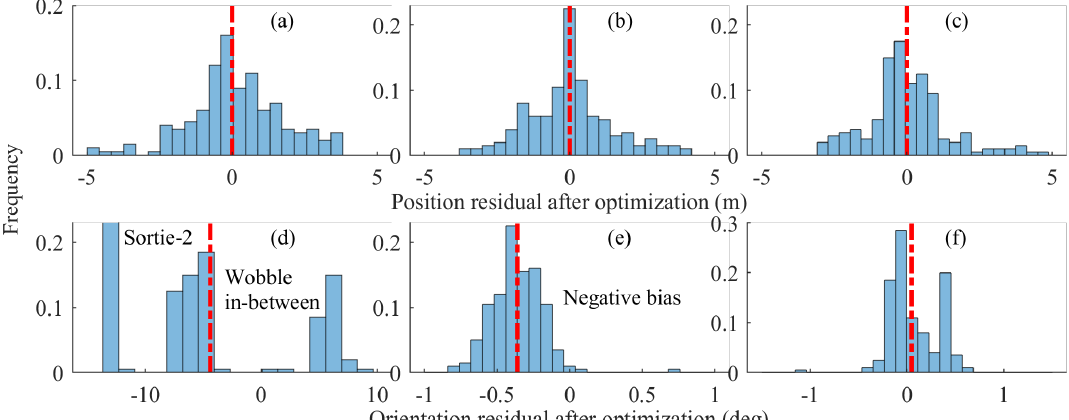
Figure 8. The POS residual histograms of all 200 photos from the three sorties after alignment optimization in Agisoft R (cid:13) PhotoScan, through which sparse cloud points were produced. ( a – c ) are for the positional records, X , Y , and Z , respectively, whose bell-shaped distributions are zero-centred (similar to Gaussian forms). The ( d – f ) are for the orientational records, yaw, pitch, and roll, respectively, whose distributions are much more complicated than that of the positional